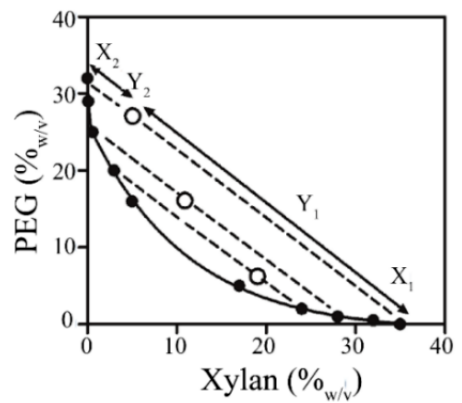
Figure 2. Phase diagram of xylan and PEG solutions. The solid line (–) represents the binodal line and the dashed lines (- - -) or the tie-lines. Below the binodal lines, the systems have just one phase, and, above it, the open circle ( ○ ) represents the point at which the phase separation occurs. X 1 stands for the xylan dispersion at 40% (w/v) , X 2 is the PEG enriched solution 32% (w/v) , and Y 1 and Y 2 represent the volume ratio of the two phases for the formation of the emulsions.